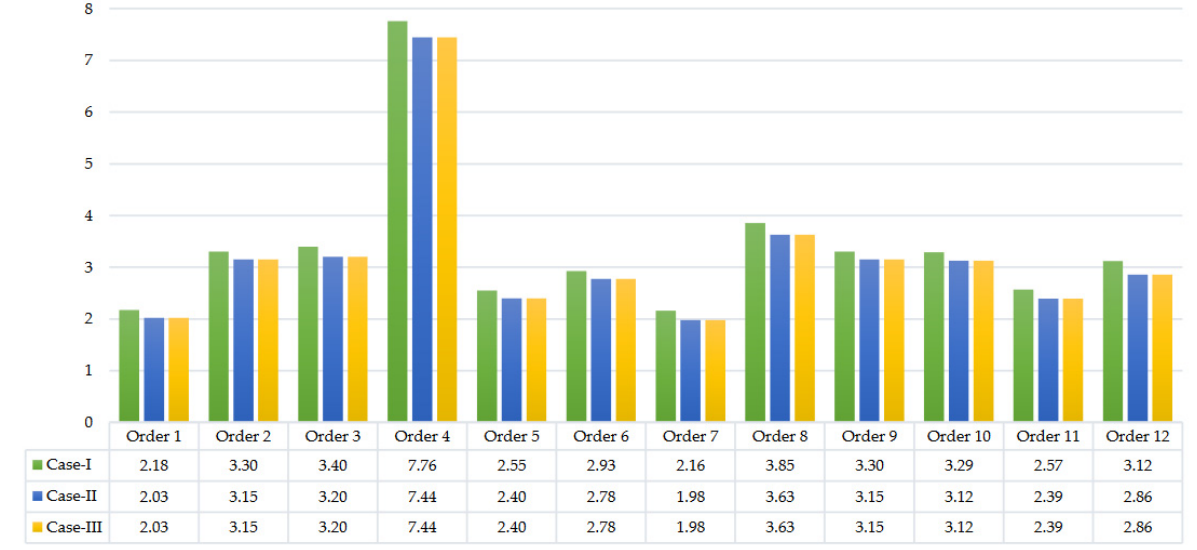
Figure 3. Processing time (minutes) of each order in different cases when the processing of orders in Case-III are considered non-simultaneously.